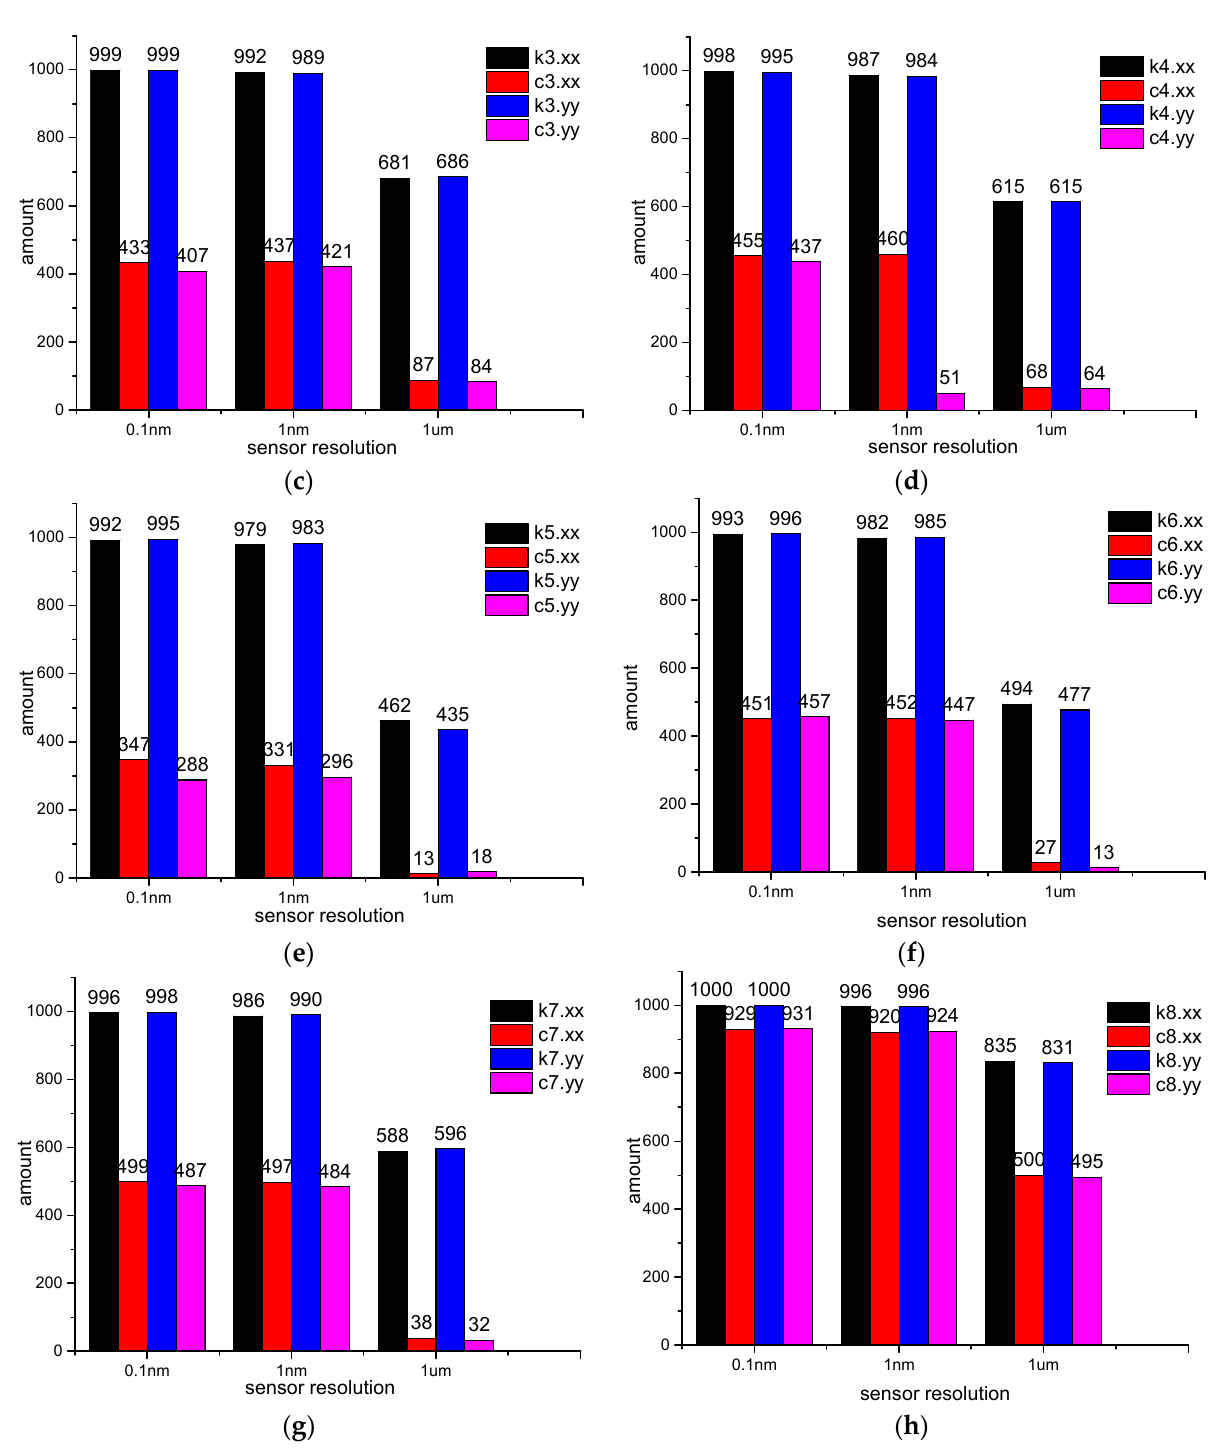
Figure 7. Statistical results of the amount of the frequencies, at which the related error is less than 10%: ( a ) #1 bearing; ( b ) #2 bearing; ( c ) #3 bearing; ( d ) #4 bearing; ( e ) #5 bearing; ( f ) #6 bearing; ( g ) #7 bearing; ( h ) #8